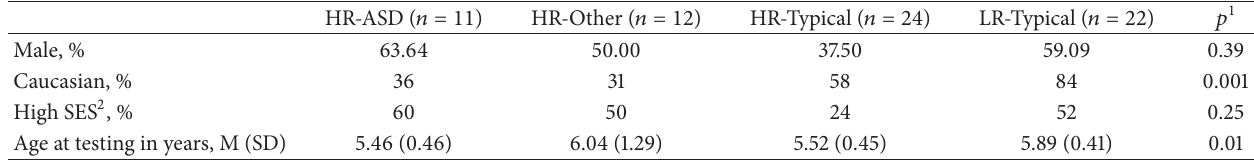
Table 1: Participant characteristics by